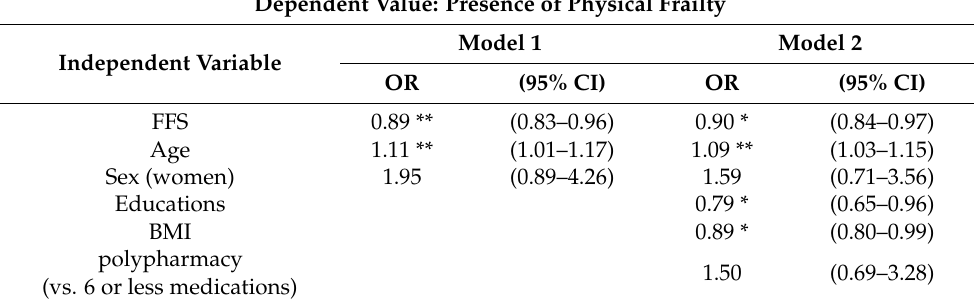
Table 2. Association between food frequency score and physical frailty.